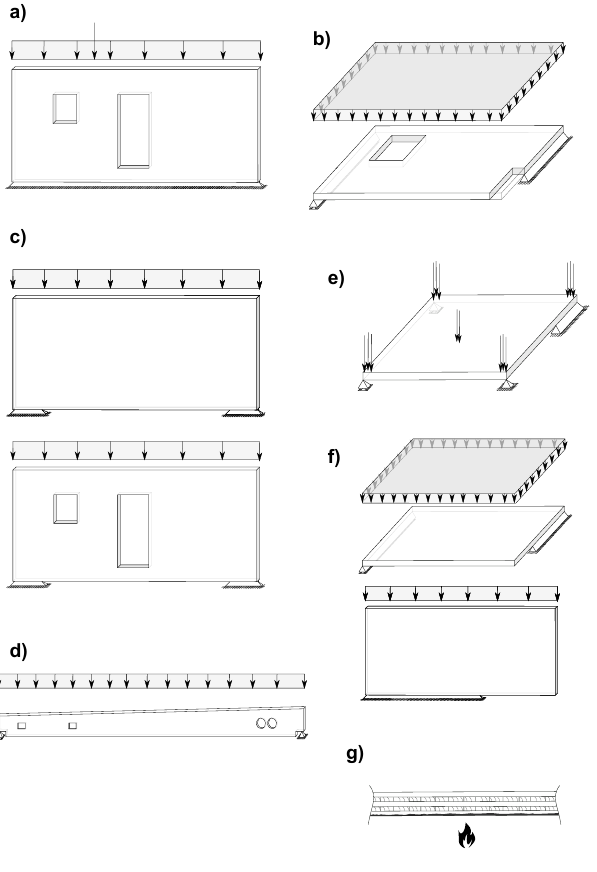
Figure 13. Challenging design situations for cross laminated timber (CLT): ( a ) openings in walls, ( b ) openings in floors, ( c ) deep CLT beams (with openings), ( d ) CLT beams (with openings), ( e ) point supports and concentrated loads, ( f ) cantilevers, ( g ) asymmetrical